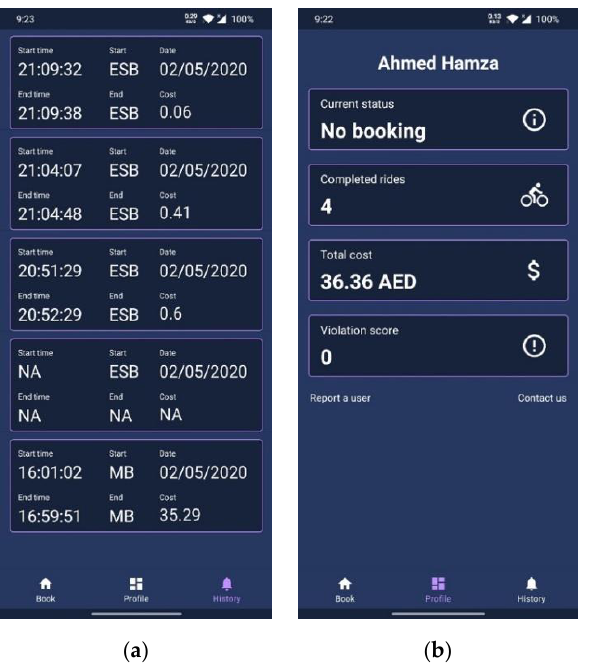
Figure 13. User interface profile and ride history: ( a ) User rides history ( b ) User profile interface.